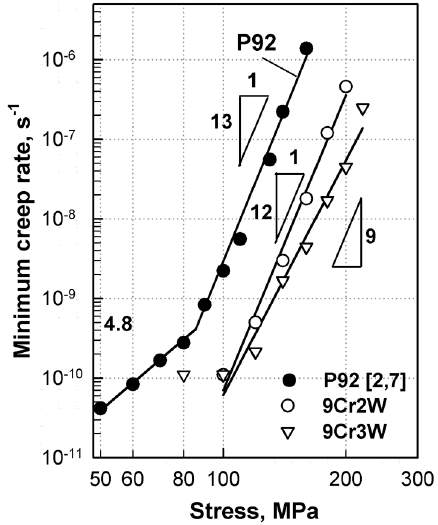
Figure 4. Minimum creep rate as a function of time to rupture for the 9Cr2W and 9Cr3W steels in comparison with data for the P92 steel [2,7].